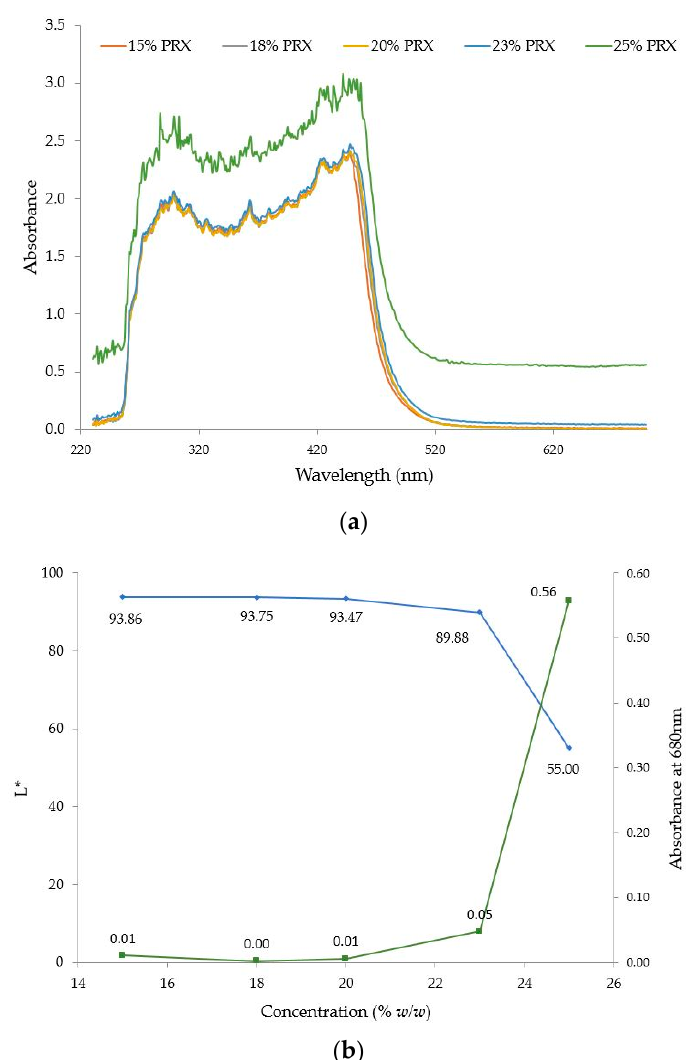
Figure 15. ( a ) Absorbance spectra of extrudate with PRX concentrations from 15% to 25% w / w . ( b ) L* and absorbance values at 680 nm of PRX/polymer extrudates with API concentrations from 18 to 25% w / w .